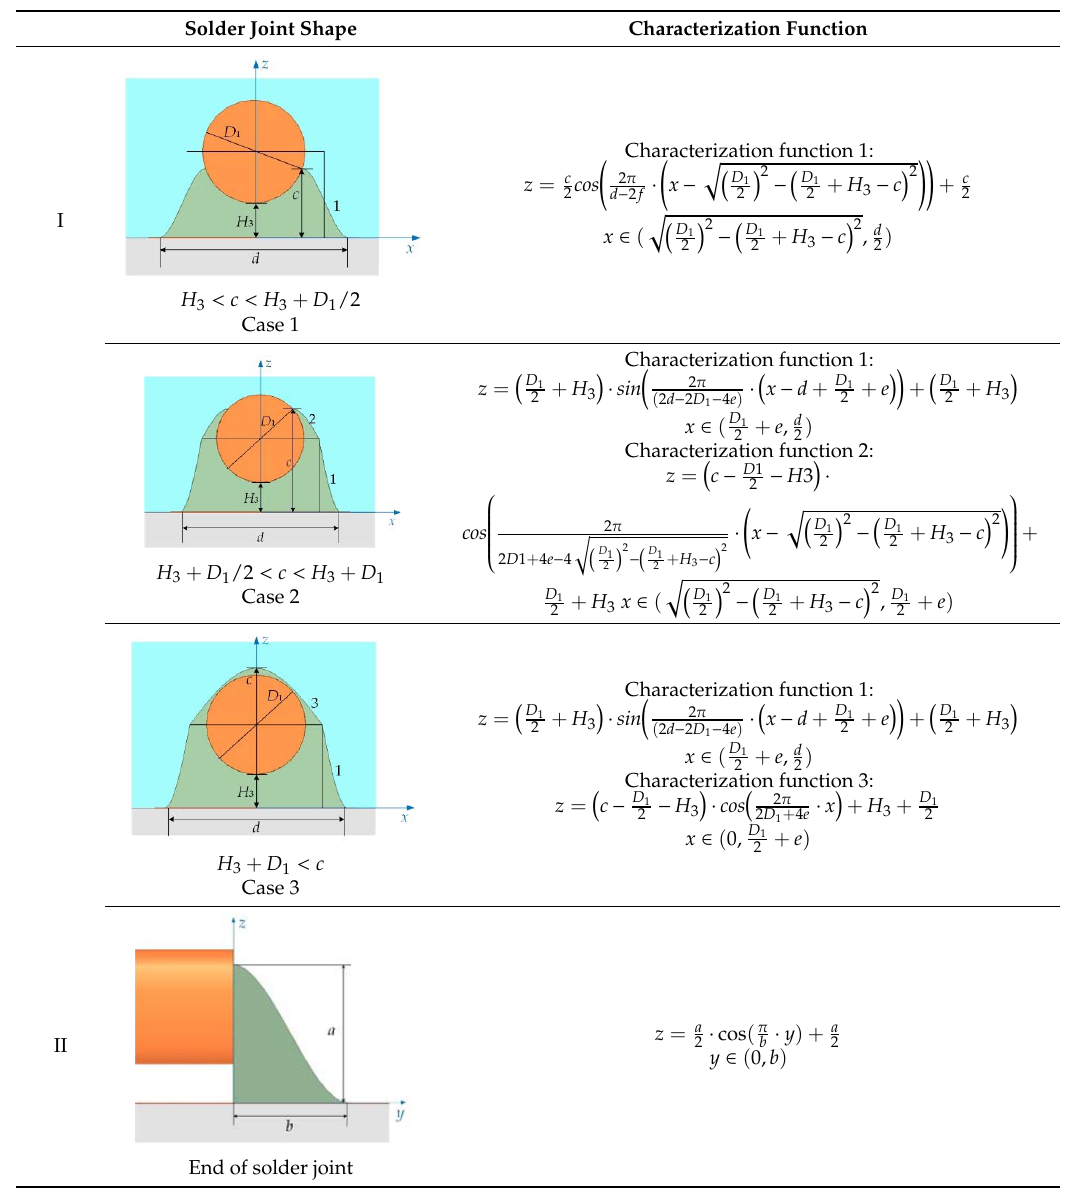
Table A2. Parameterized